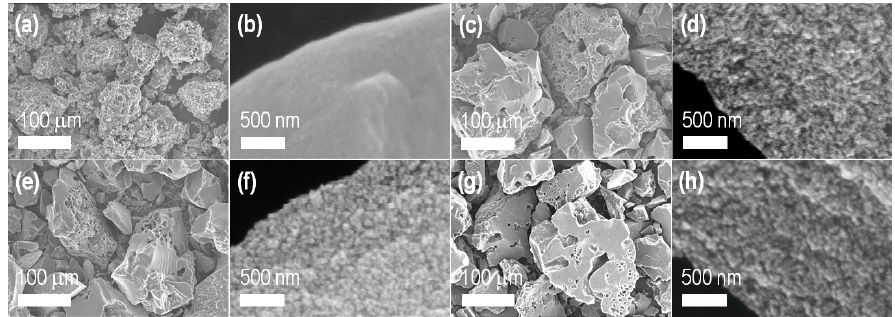
Figure 1. SEM images of the prepared nanoporous activated carbons from Jack fruit seed: ( a , b ) JFS_800; ( c , d ) JFSC_Z600; ( e , f ) JFSC_Z800; ( g , h )